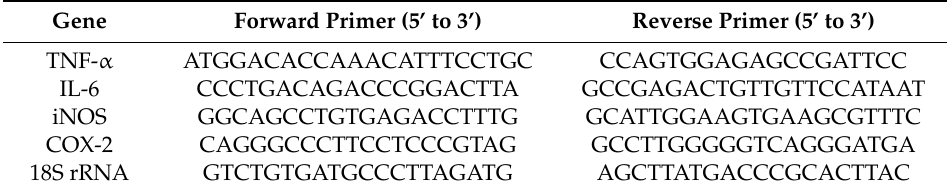
Table 1. The mRNA expressions were normalized to the expression of the housekeeping gene 18S rRNA. Table 1. Primer sequences for real-time PCR.